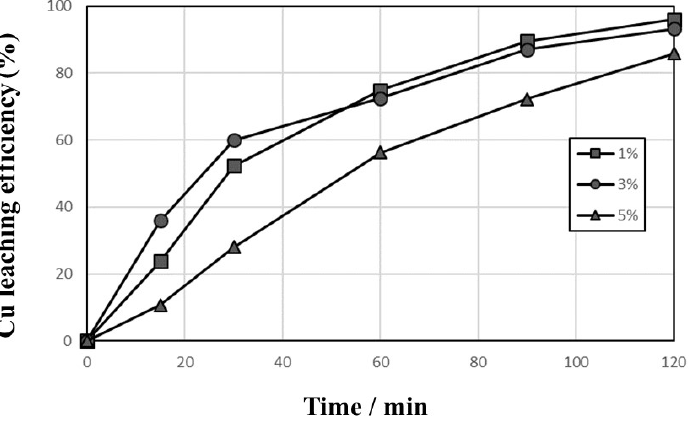
Figure 7. Effects of pulp density on the leaching behaviors of Cu in 1 mol/L sulfuric acid solution at 90 °C and 600 rpm with 10,000 mg/L Cu 2+ , 1–5% pulp density, and 1000 cc/min O 2 introduction.